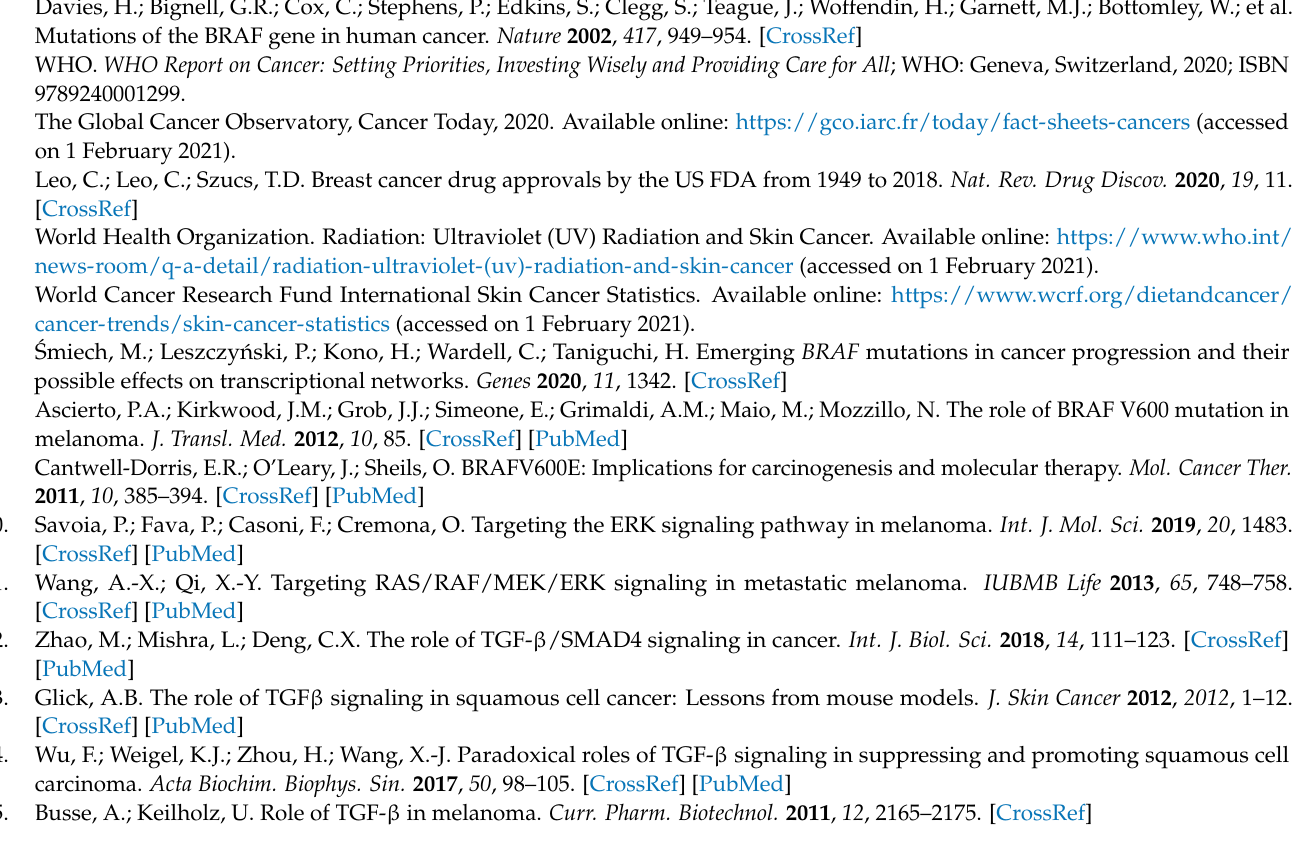
Table S2: List of primers used in EAC, B16-F0 and NIH-3T3 cells; Table S3: ADMET properties of the test compound from admetSAR; Table S4: Effect of 3-MBTSc on expression of different genes in EAC cells; Table S5: Effect of 3-MBTSc on genes expression in B16-F0 cells; Table S6: Effect of 3-MBTSc on different genes expression in MCF-7 cells; Table S7: Effect of 4-NBTSc on selected genes expression in EAC cells; Table S8: Effect of 4-NBTSc on genes expression in B16-F0 cells; Table S9: Effect of 4-NBTSc on genes expression in MCF-7